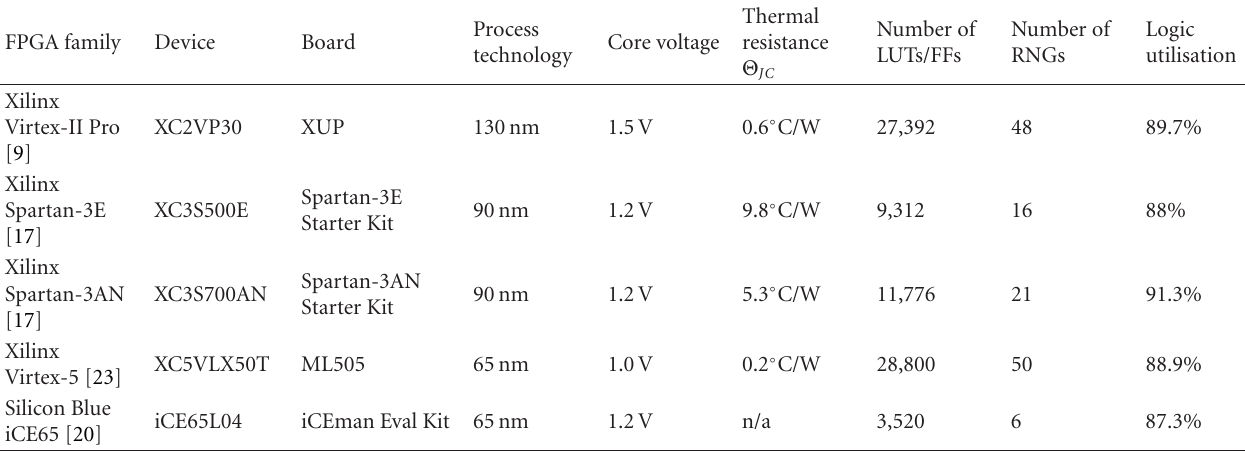
Table 3: Details of FPGAs used for our fabric characterisation experiment.